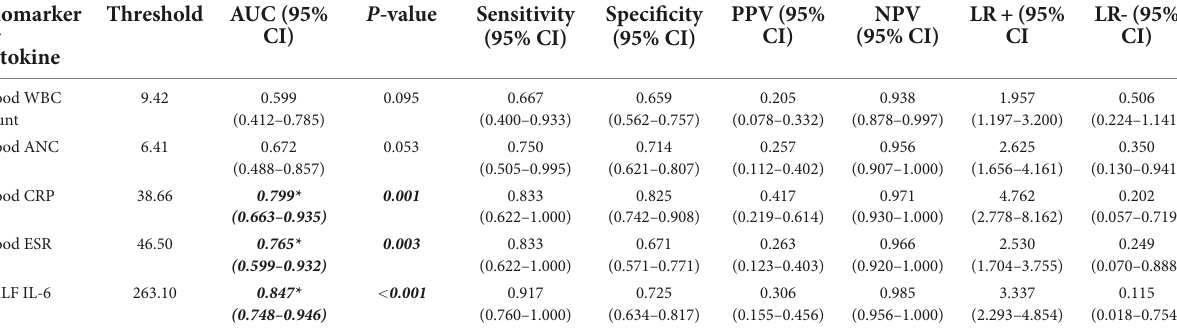
TABLE 2 Performance characteristics of biomarkers or cytokines in blood/BALF to predict severe cases vs. non-severe cases with CAP.